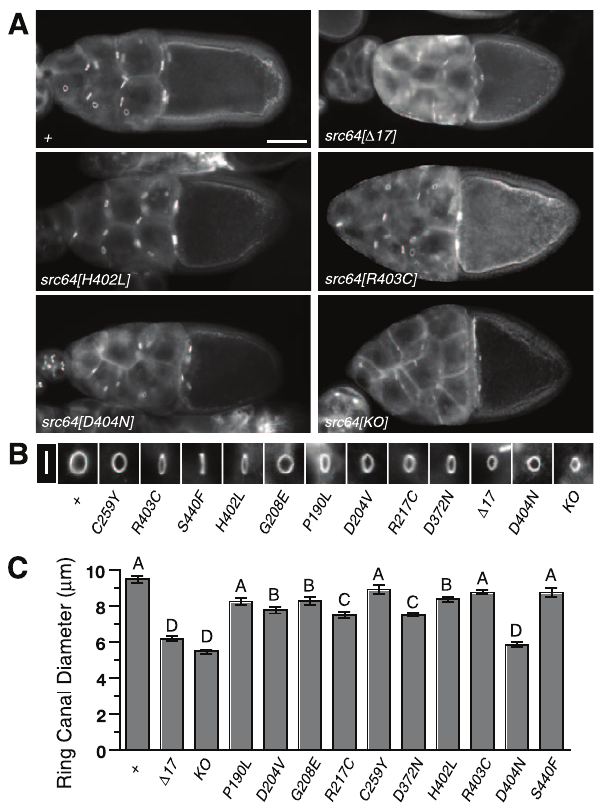
Figure 1. Ring canal growth defects in src64 mutant egg chambers. Ring canals are stained with antibody to HTS. (A) Egg chambers. Ring canal diameters are reduced in the src64 D 17 , src64 H402L , src64 D404N and src64 KO mutants. Scale bar, 50 m m. (B) Typical ring canals ordered mean by diameter and oriented so diameter is presented along the vertical axis. Scale bar, 10 m m. (C) Ring canal diameters. A, does not differ from + ; B, differs from + (P , 0.05), but not other A alleles, except src64 D204V differs from src64 R403C (P , 0.05); C, differs from + (P , 0.001) and from A alleles (P , 0.05) except src64 P190L , but not from group B, except src64 D372N differs from src64 H402L (P , 0.01); D, does not differ from src64 KO , but differs from all other alleles (P , 0.001). Error bars are SEM.